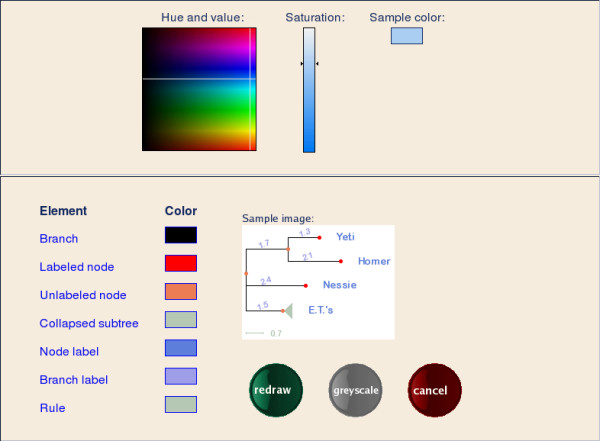
The screen for choosing colors. The user chooses a sample color by clicking in the color palette and saturation bar, then confers this color to some element, e.g. 'labeled node', by clicking its name in the table. The sample image is updated accordingly. To use the new colors, the user clicks the 'redraw' button. Otherwise, (s)he may click the 'cancel' button – or the 'greyscale' button to use greyscale colors.